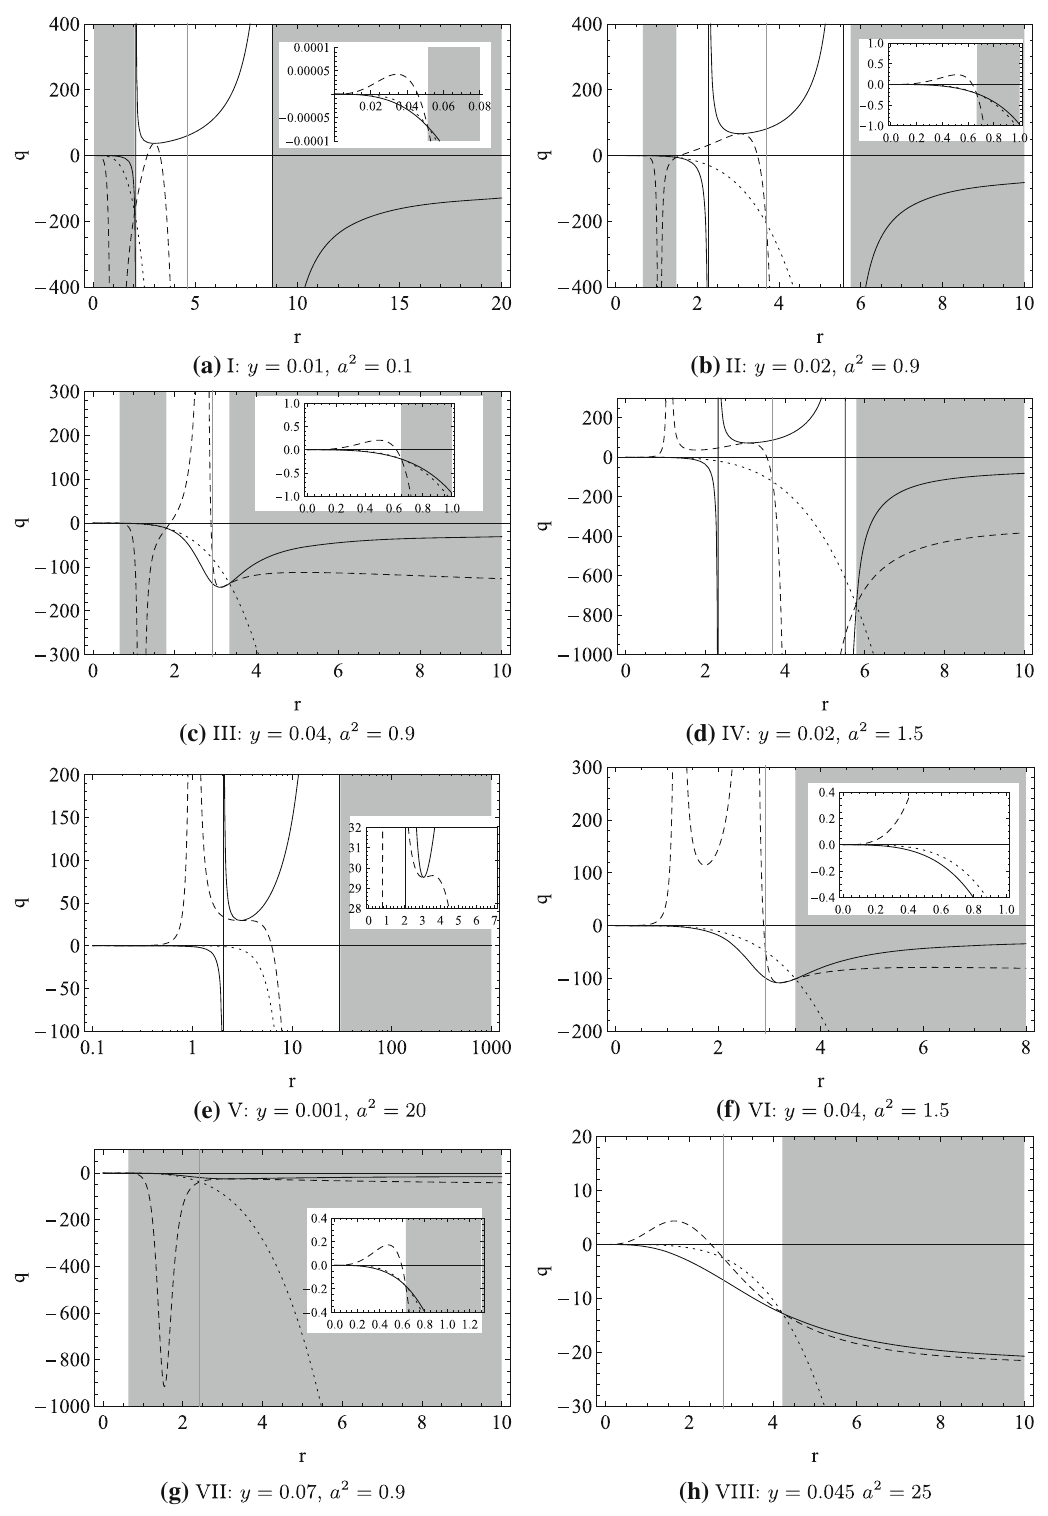
Fig. 8 Characteristic functions q r ( r ; y , a 2 ) (full curve), q ex ( r ; y , a 2 ) (dashed curve) and q ex1 ( r ; y , a 2 ) (dotted curve) governing the behav- ior of effective potentials X ± ( r ; q , y , a ). The dynamic region is high- lighted by shading, the gray vertical bar demarcates the loci of the static